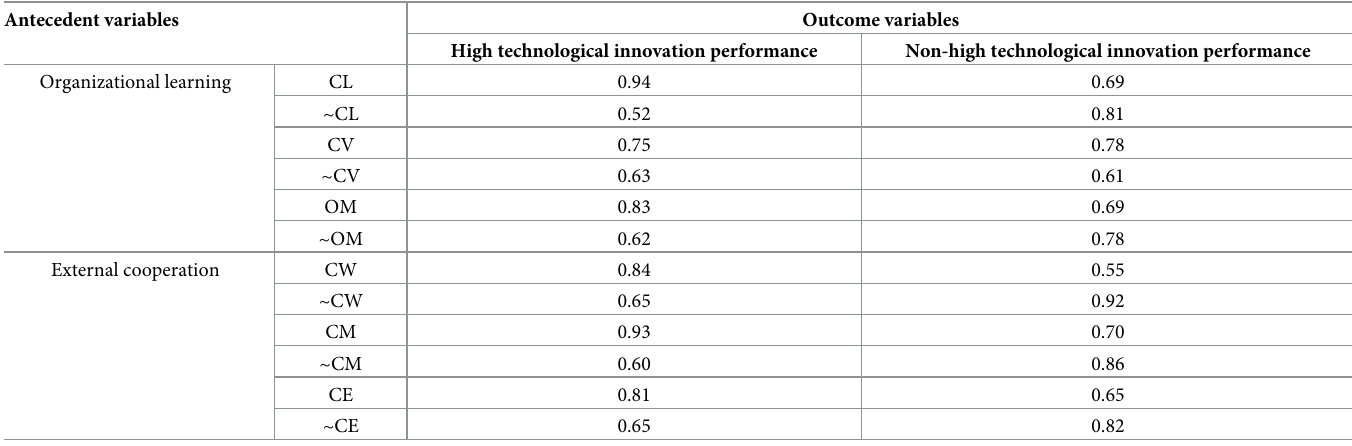
Table 4. Necessity test of antecedent conditions. Antecedent variables Outcome